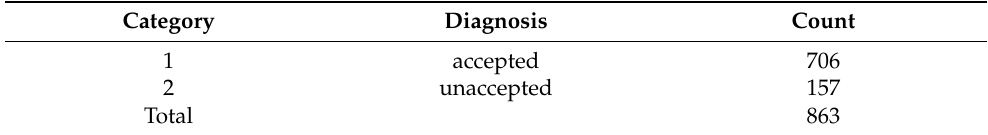
Table 3. Composition of the